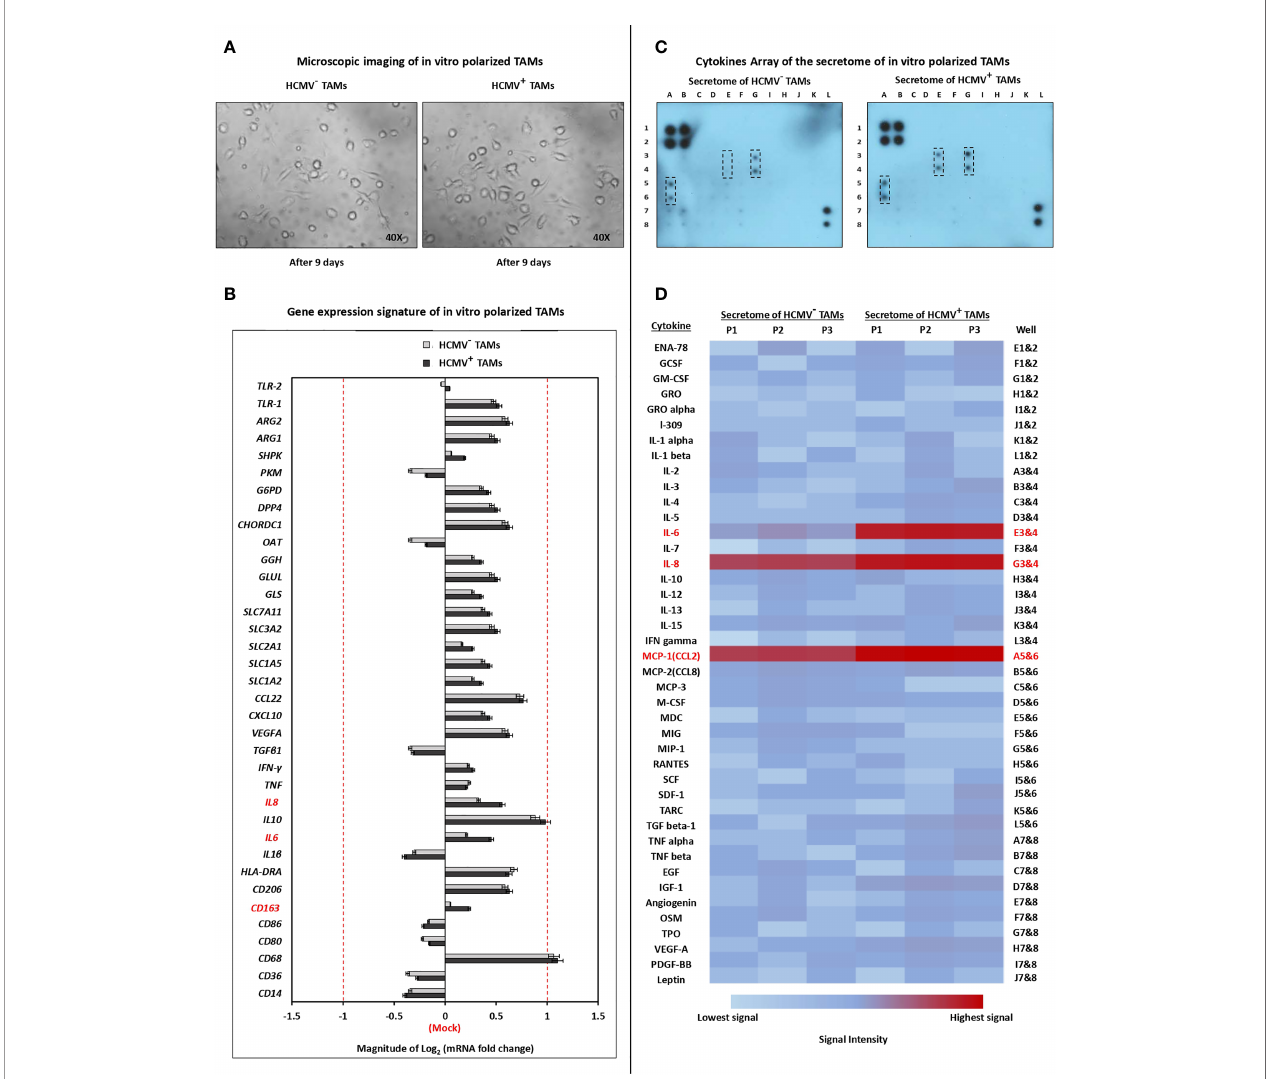
FIGURE 2 | Characterization of polarized TAMs via microscopic examination, quantitative Real-time PCR, and cytokine array. (A) Microscopic images show polarization status of TME CD14 + monocytes isolated from HCMV - and HCMV + IBC patients. (M0) were identi fi ed as small/roundish cells without cytoplasmic projections on the cell surface, (M1) were identi fi ed as enlarged amoeboid cells characterized by presence of many delicate cytoplasmic extensions on the cell surface with visible intracellular vacuoles, and (M2) were identi fi ed as a large and elongated “ spindeloid ” cells with cytoplasmic extensions on the apical ends of the cell bodies. (B) Clustered bars represent the mRNA expression of macrophage polarization-related genes in HCMV - and HCMV + polarized TAMs compared to mock cells. (C) Membrane-based cytokine pro fi ling array. Spots represent the signal intensity value of each cytokine, calculated using ImageJ software (NIH, Bethesda, MA, USA) and normalized according to an algorithm provided in the cytokine antibody array kit instruction manual. (D) Heat map showing expression levels of 42 cytokines in HCMV - versus HCM + polarized TAMs. Genes and cytokines in red color are signi fi cantly highly expressed in HCMV + TAMs compared to HCMV -